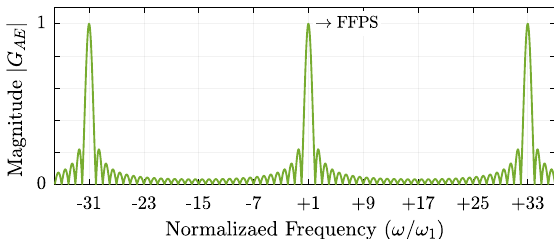
Figure 9. Magnitude graph of operation FFPS-GDSC as a function of normalized